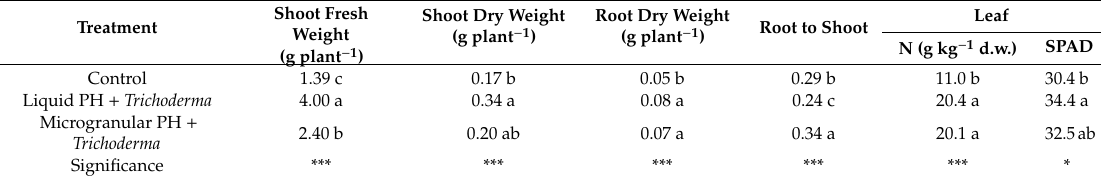
Table 4. E ff ect of biostimulant treatments on dry weight of shoots and roots, root to shoot ratio and nitrogen content, and Soil-Plant Analysis Development (SPAD) index of leaves in tomato transplants (Experiment